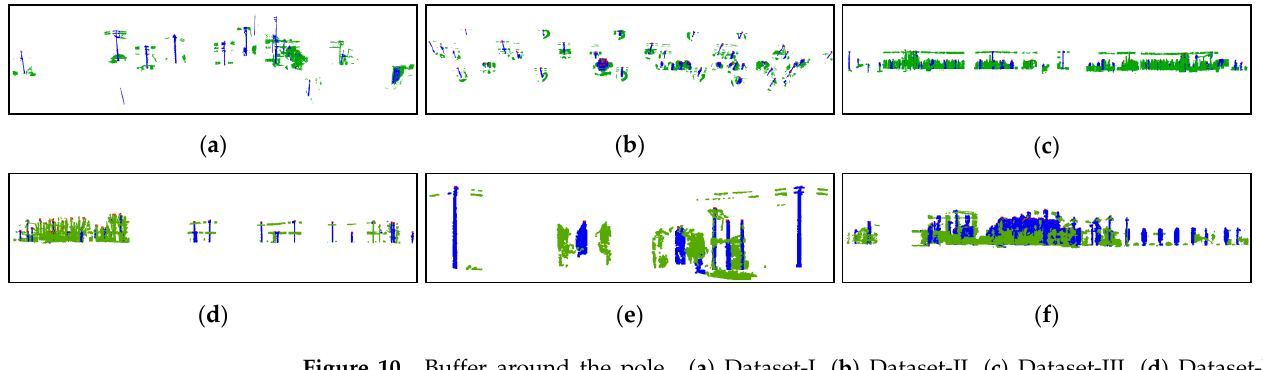
Figure 10. Buffer around the pole. ( a ) Dataset-I. ( b ) Dataset-II. ( c ) Dataset-III. ( d ) Dataset-IV. ( e ) Dataset-V. ( f ) Dataset-VI. (2) Result of candidate telegraph pole location